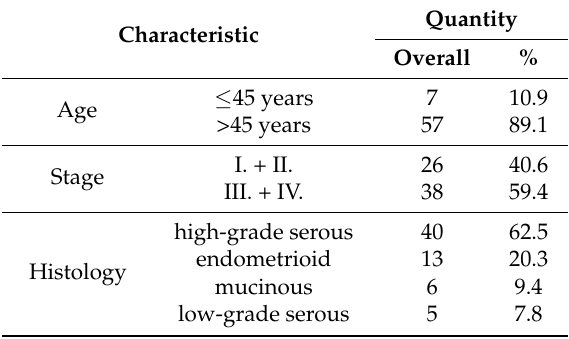
Table 2. Clinicopathological data of patients with ovarian cancer (OC). Characteristic